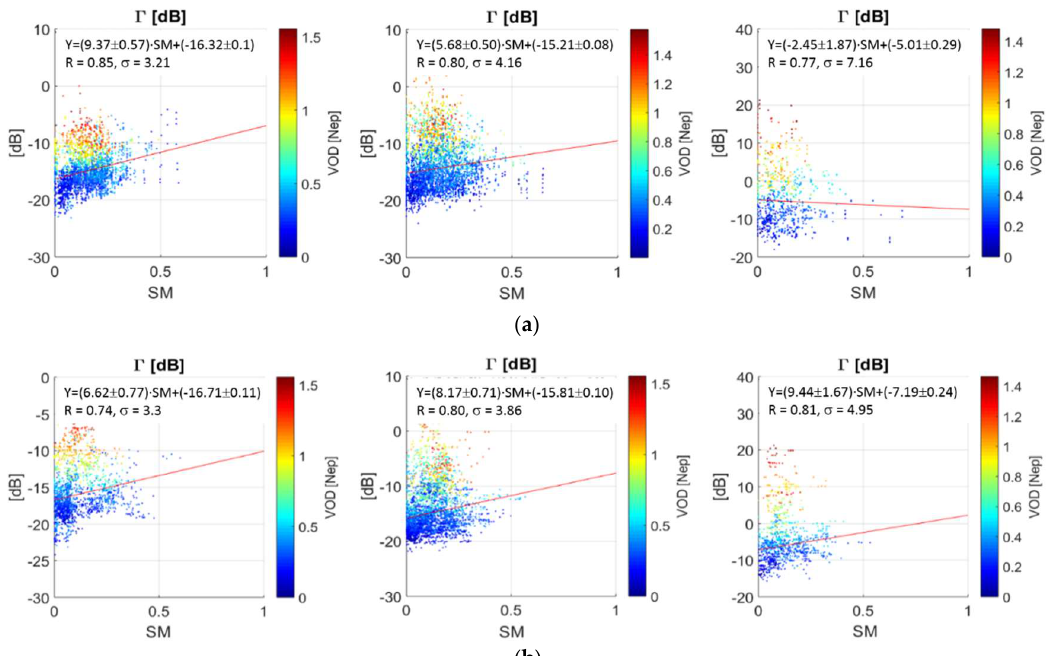
Figure 13. Scatter plot between the ( a ) Low Resolution (25 km) SMOS L3 SM and ( b ) High Resolution (1 km) SMOS L4 SM and the TDS-1 reflectivity value over the CEMADEM region from June 2016 to June 2017, with vegetation and roughness corrections applied. Each column represents the values for a specific range of incidence angles: ( left ) 0 ◦ –30 ◦ ; ( center ) 30 ◦ –60 ◦ ; and ( right ) 60 ◦ –90 ◦